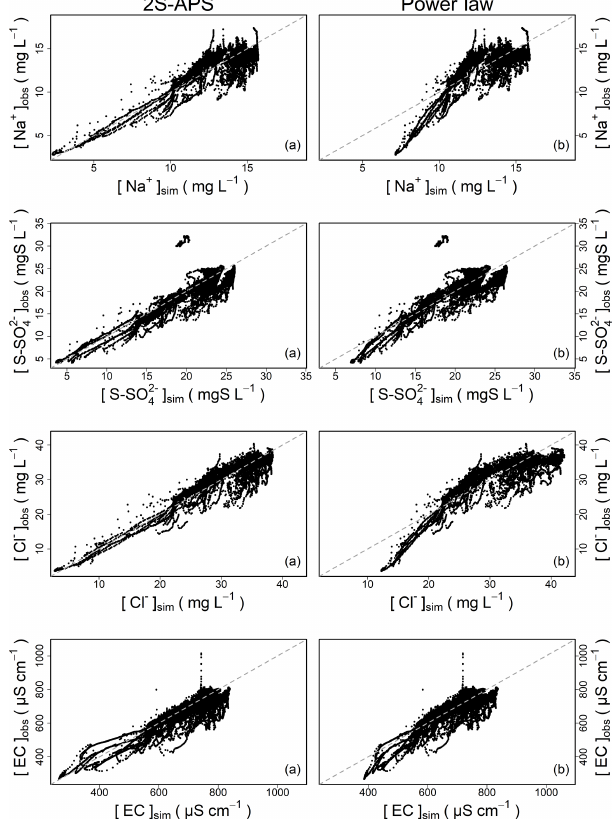
Figure 4. Comparison of simulated concentrations with observed concentrations for (a) two-sided affine power scaling (2S-APS) re- lationship, (b) power law (calibration